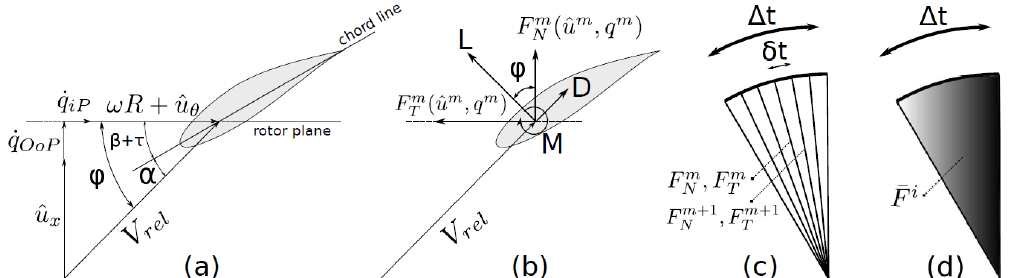
Figure 4. The AASM comprises the following steps: (a) evaluation of the angle of attack from the airfoil’s cross-section velocity triangle and blade’s motion, (b) the local cross-section forces are computed from 2D airfoil data, (c) the blades sweep a sector area using a sub-cycling scheme, and (d) the sector area forces are time-filtered. Panel (d) denotes that more weight is given to the forces in the end position. Figure taken from Vitsas and Meyers (2016).